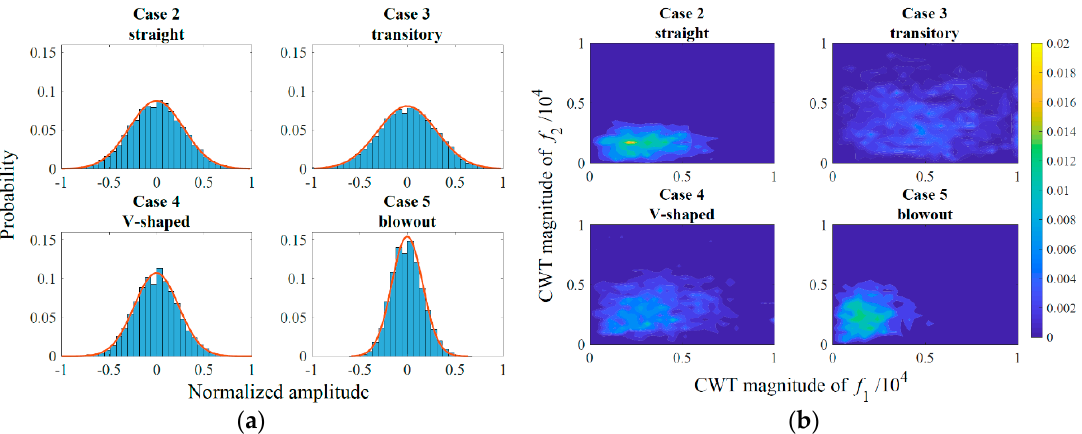
Figure 6. ( a ) Histograms of the pressure signal at characteristic flame shapes. ( b ) Joint histograms of CWT coefficients at f 1 and f 2 of Cases 2–5.